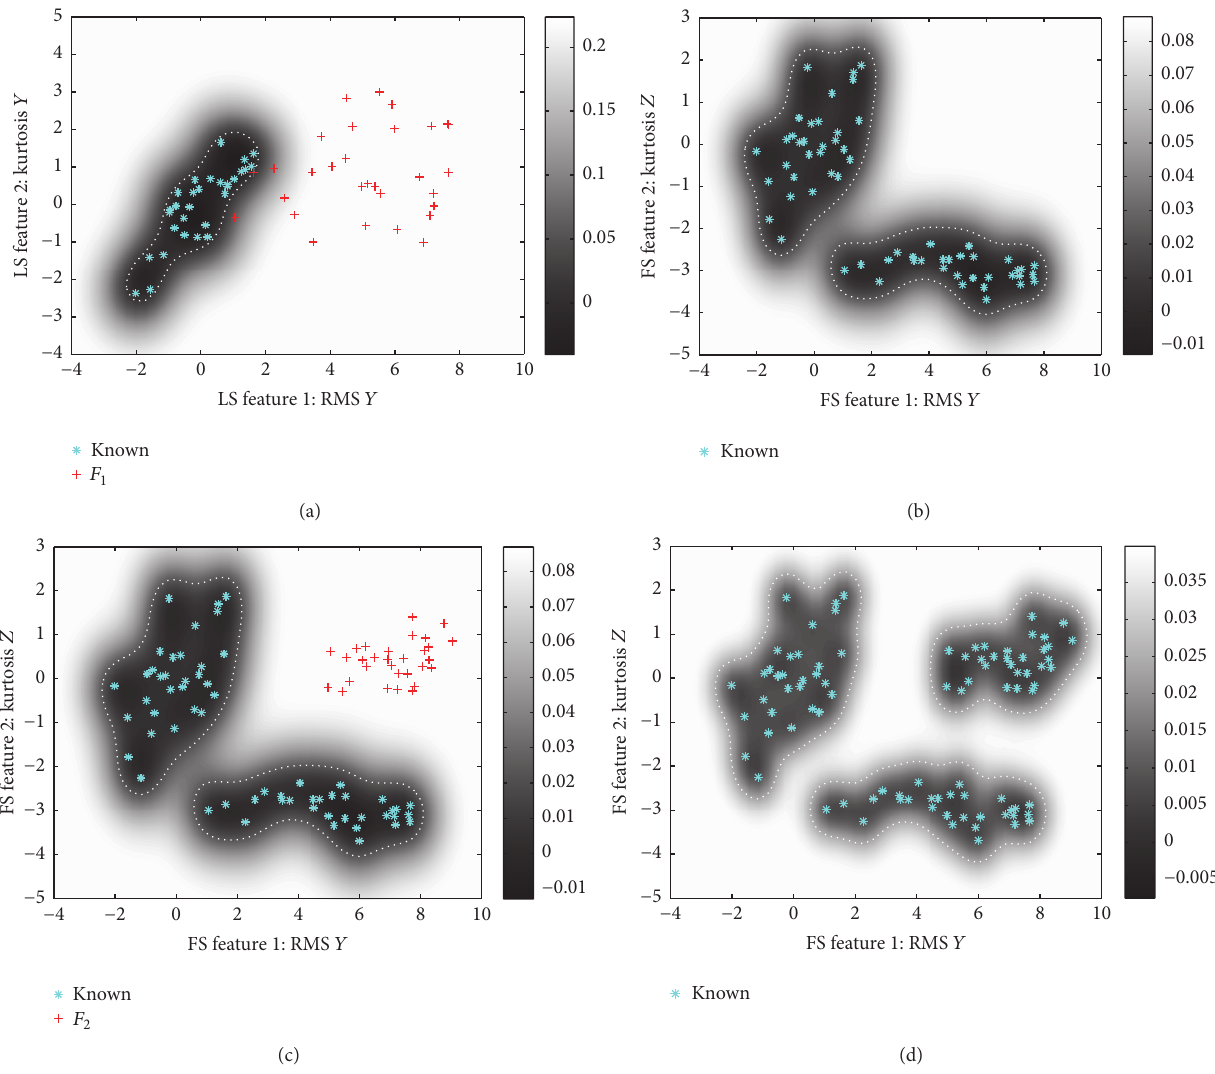
Figure 9: Process of evaluation and retraining employing the methodology proposed. (a) Evaluation of the fault scenario 𝐹 1 . (b) Retraining of the novelty model and reformulation of the reduced set of features including 𝐹 1 . (c) Evaluation of the fault scenario 𝐹 2 . (d) Retraining of the novelty model and reformulation of the reduced set of features including 𝐹 2 . Table 1: Performance of the novelty detection using only healthy class data to reduce the number of features, where DR stands for dimensionality reduction. Different scenarios are included according to the information available to train and test the novelty model.